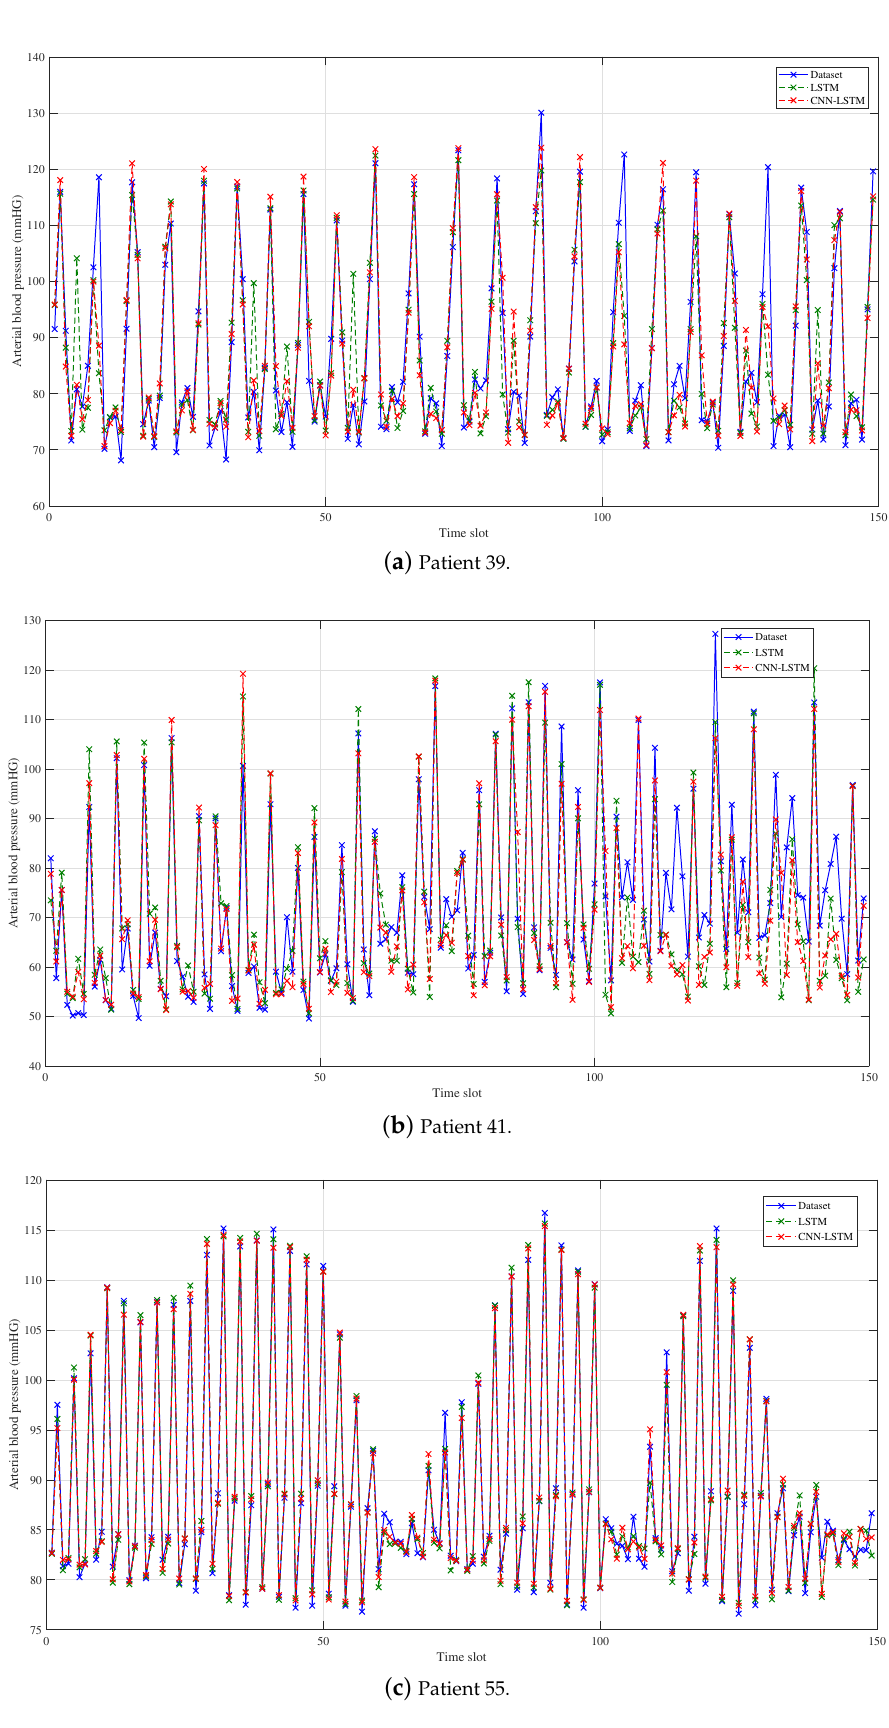
Figure 5. Prediction results of LSTM and